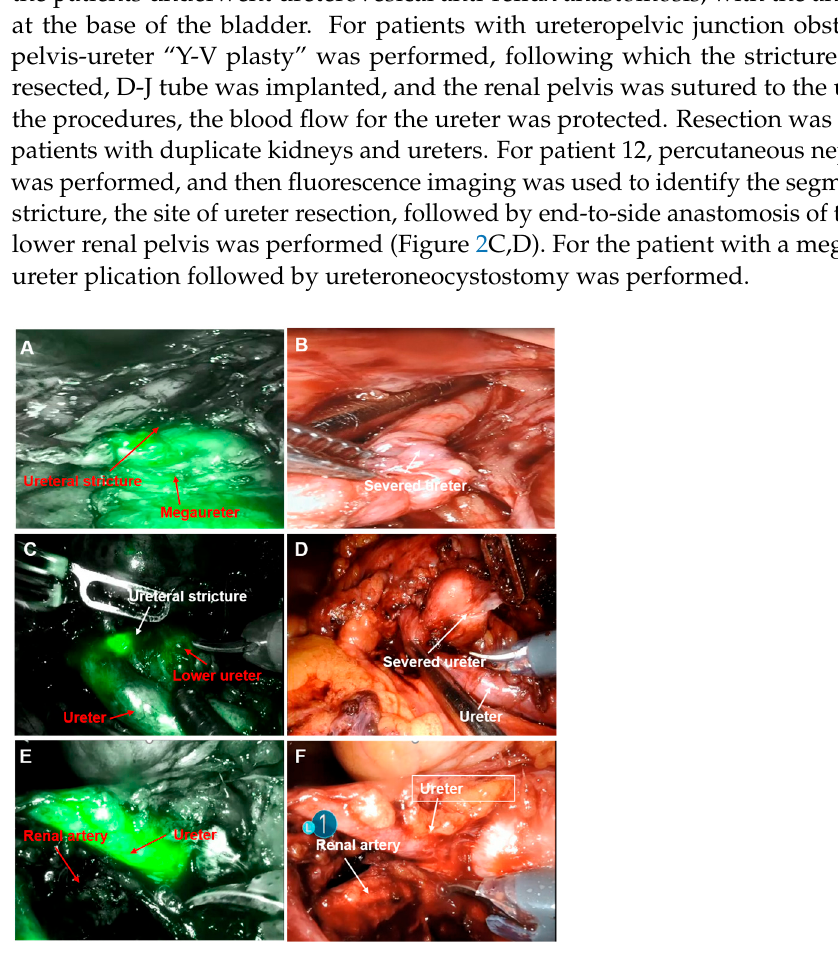
Figure 2. Fluorescence positioning of the ureter and the segment of the ureteral stricture. ( A , B ): Fluorescence imaging by Da Vinci robot in combination with white light imaging for the positioning of stricture of the lower ureter; ( C , D ): positioning of lower ureteral stricture in a patient with duplicate kidney and duplicate ureter by Da Vinci robot fluorescence imaging, after which the ureter was resected at the site of restructure; ( E , F ): native ureter by Da Vinci robot fluorescence imaging in the patient who underwent renal transplantation, and thus the spatial correlation between the ureter and renal artery was clarified.